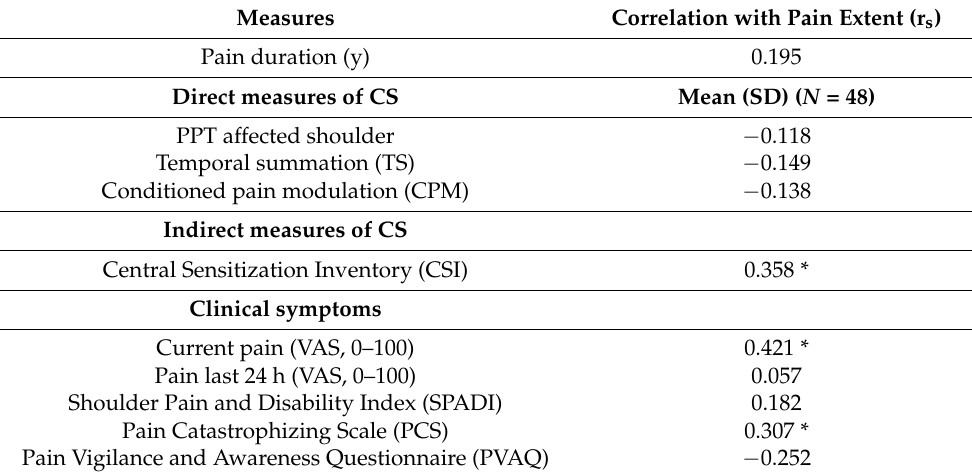
Table 2. Spearman correlation coefficients between the extent of pain (total area of pain extracted from frontal and dorsal body views) computed using pain drawings and measures of central sensitization and clinical symptoms in patients with frozen shoulder ( N = 48).